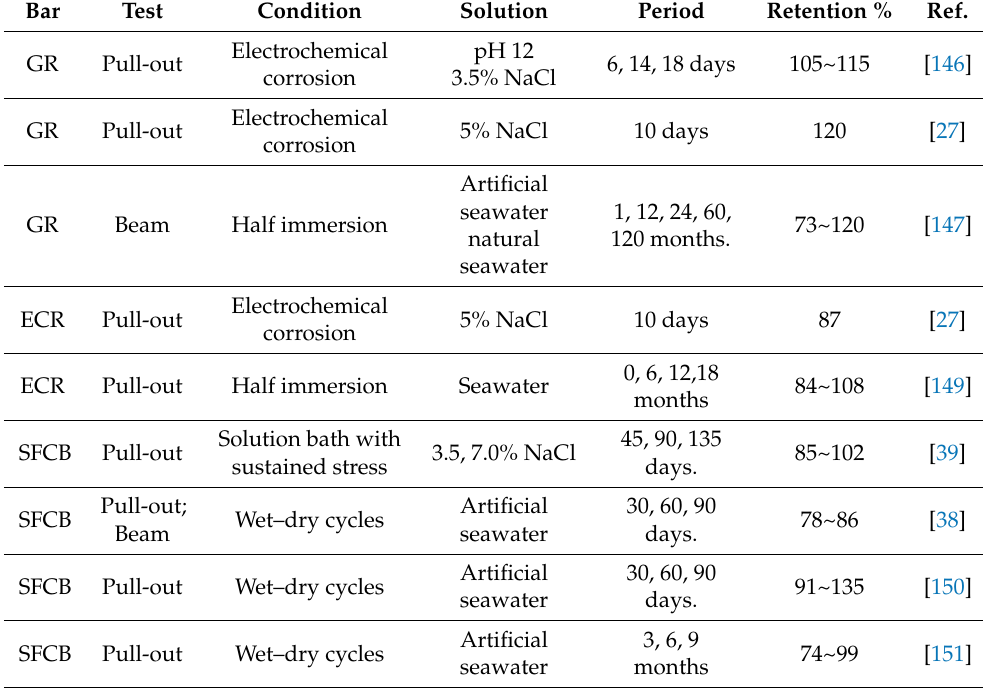
Table 7. Experiments on bond strength after